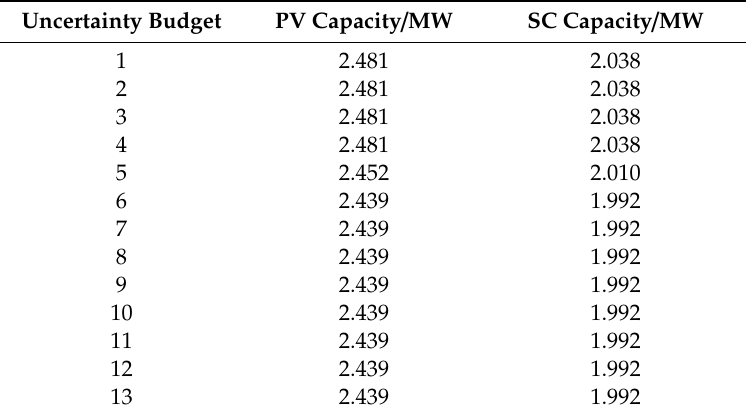
Table 3. Analysis of the results for di ff erent uncertainty